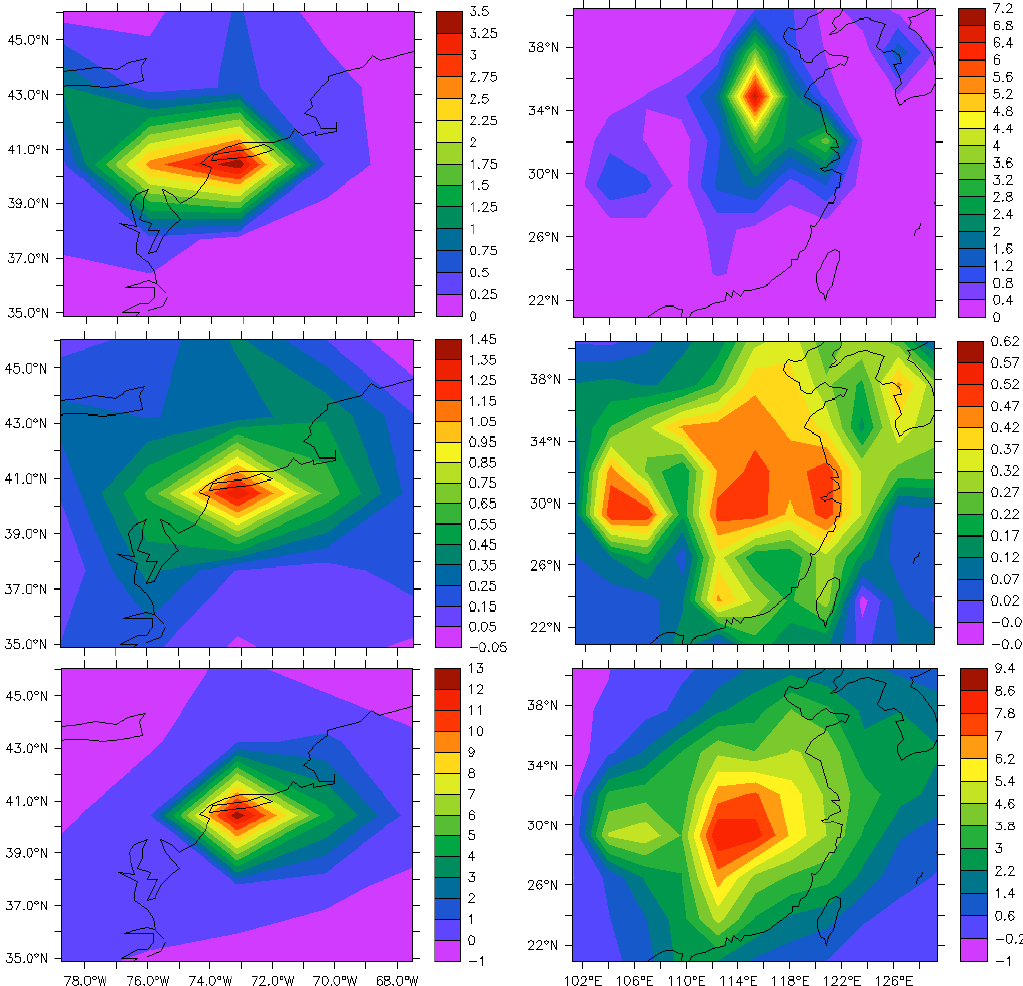
Figure 17: Simulated monthly average enhancement of OH (middle panel, 10 6 molecules cm - Fig. 17. Simulated monthly average enhancement of OH (middle panel, 10 6 moleculescm − 3 ) and O 3 (lower panel,ppbv) near the surface as a function of NO (base scenario, upper panel,ppbv) in June over the eastern USA (left) and December over eastern China 3 ) and O (lower panel, ppbv) near the surface as a function of NO (base scenario, 3